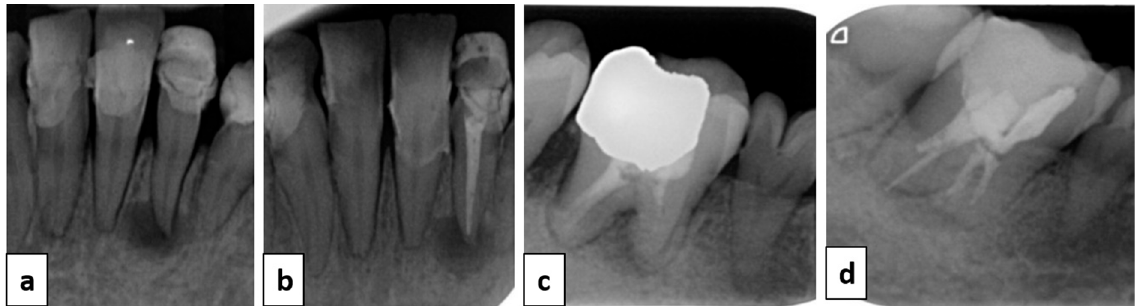
Figure 3. Endodontic treatment of teeth numbers 32 and 46. Retro-alveolar X-rays before and after endodontic therapy of tooth number 32 ( a , b ) and number 46 ( c , d ).